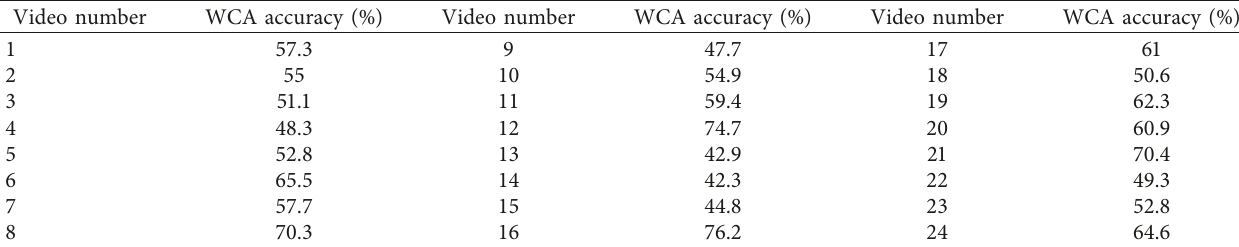
Table 4: Accuracy test